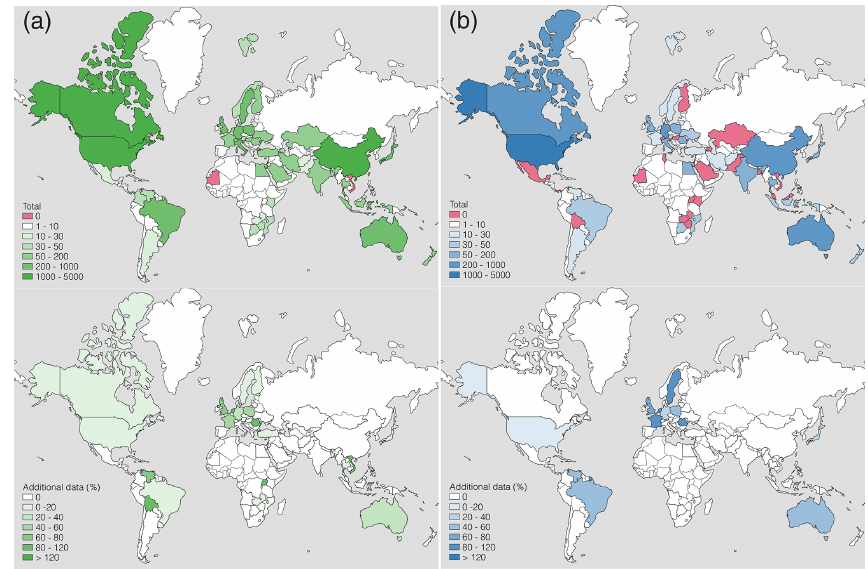
Figure 4. Number of isotopic signature measurements, (a) δ 13 C and (b) δ 2 H of CH 4 , carried out in different countries. Top maps show the total numbers reported in the new global database. Bottom maps show the percentage of additional data brought by the EMID and the new published literature compared to Sherwood et al. (2017,